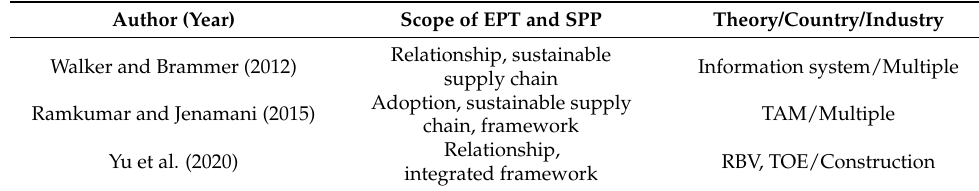
Table 1. EPT and SPP in